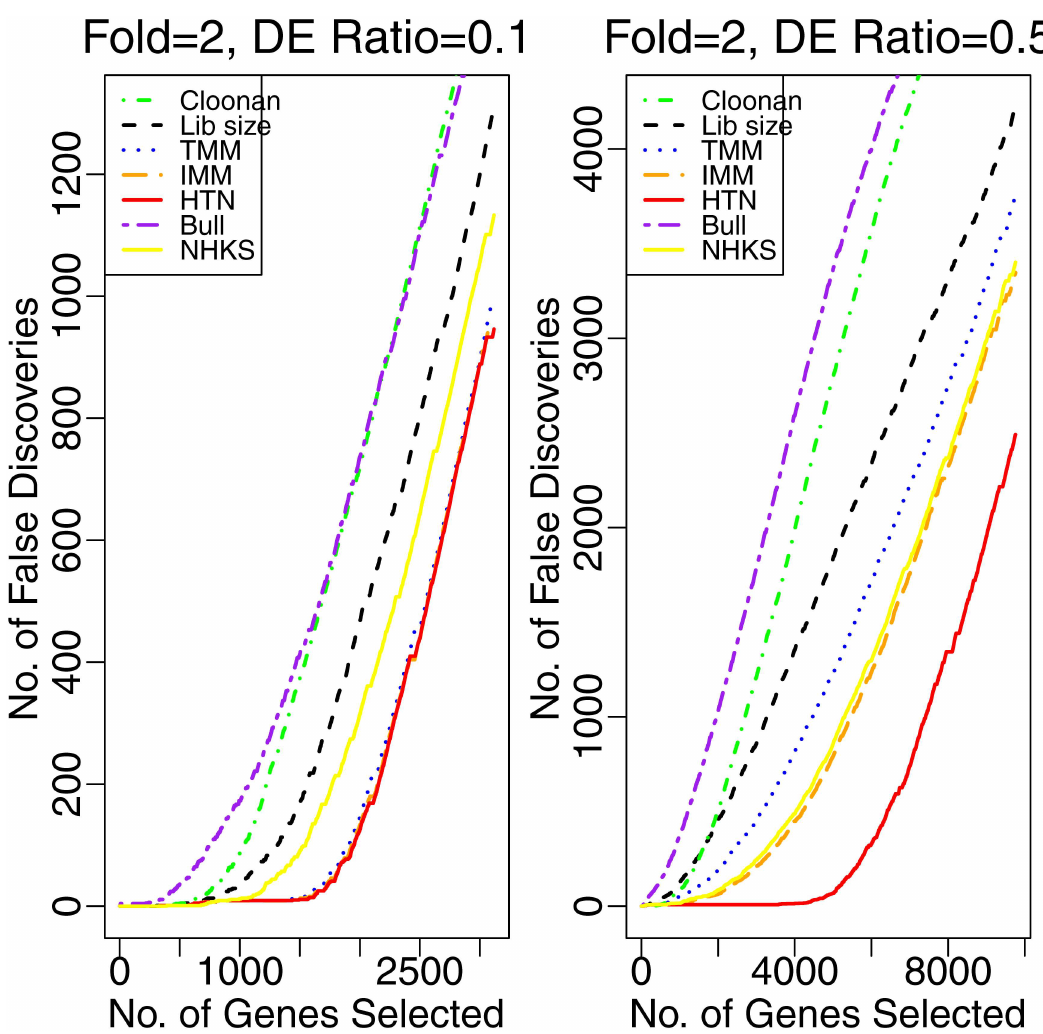
Fig 5. False discovery number for different normalization methods. The left panel and the right panel are the false discovery plots for DE genesat the rates of 0.1 and 0.5, respectively.